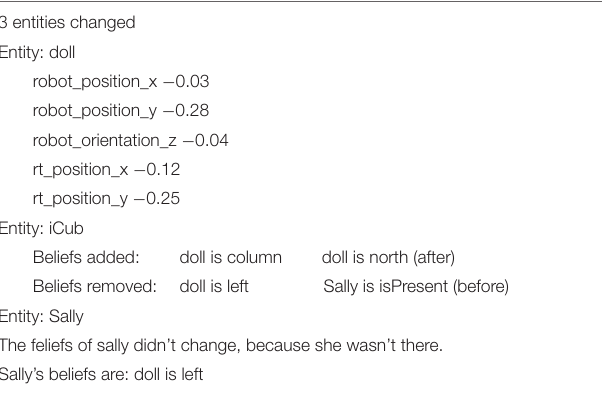
TABLE 3 | Results from comparing the “true beliefs” attributed to the iCub in the real OPC and the “false belief” attributed to Sally in the MOPC. 3 entities